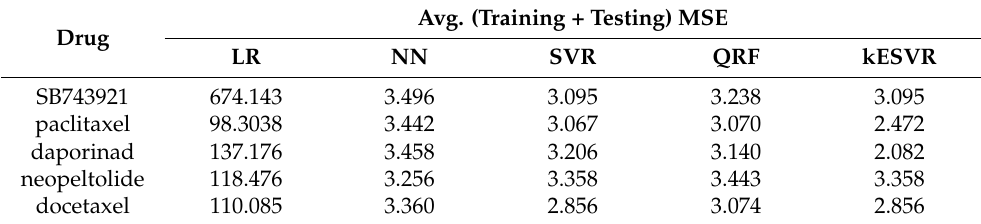
Table 4. Model comparison for 5 drugs with maximum variance.